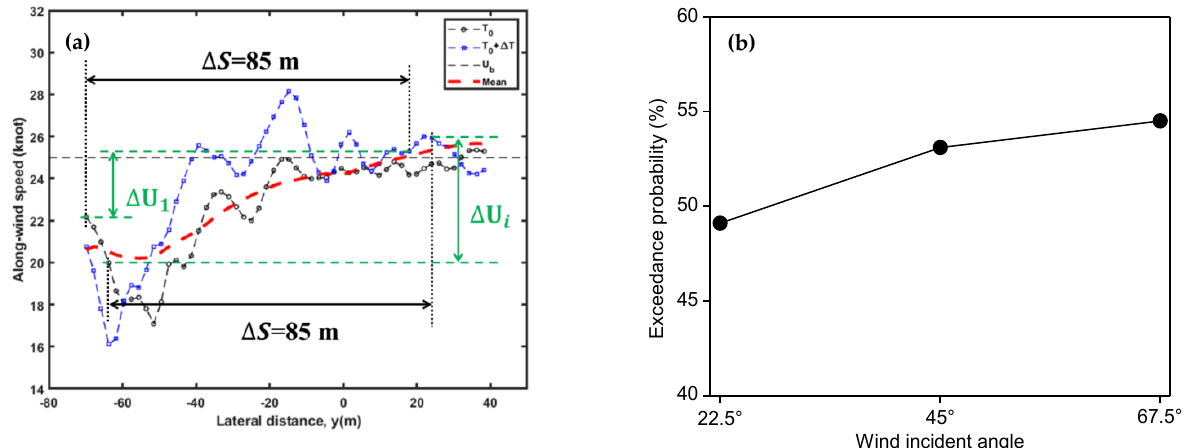
Figure 13. Scenario B: ( a ) maximum velocity difference calculation under a pre-specified time interval (1 s) and aircraft operation speed (85 m/s); ( b ) Exceedance probability at different wind angles.